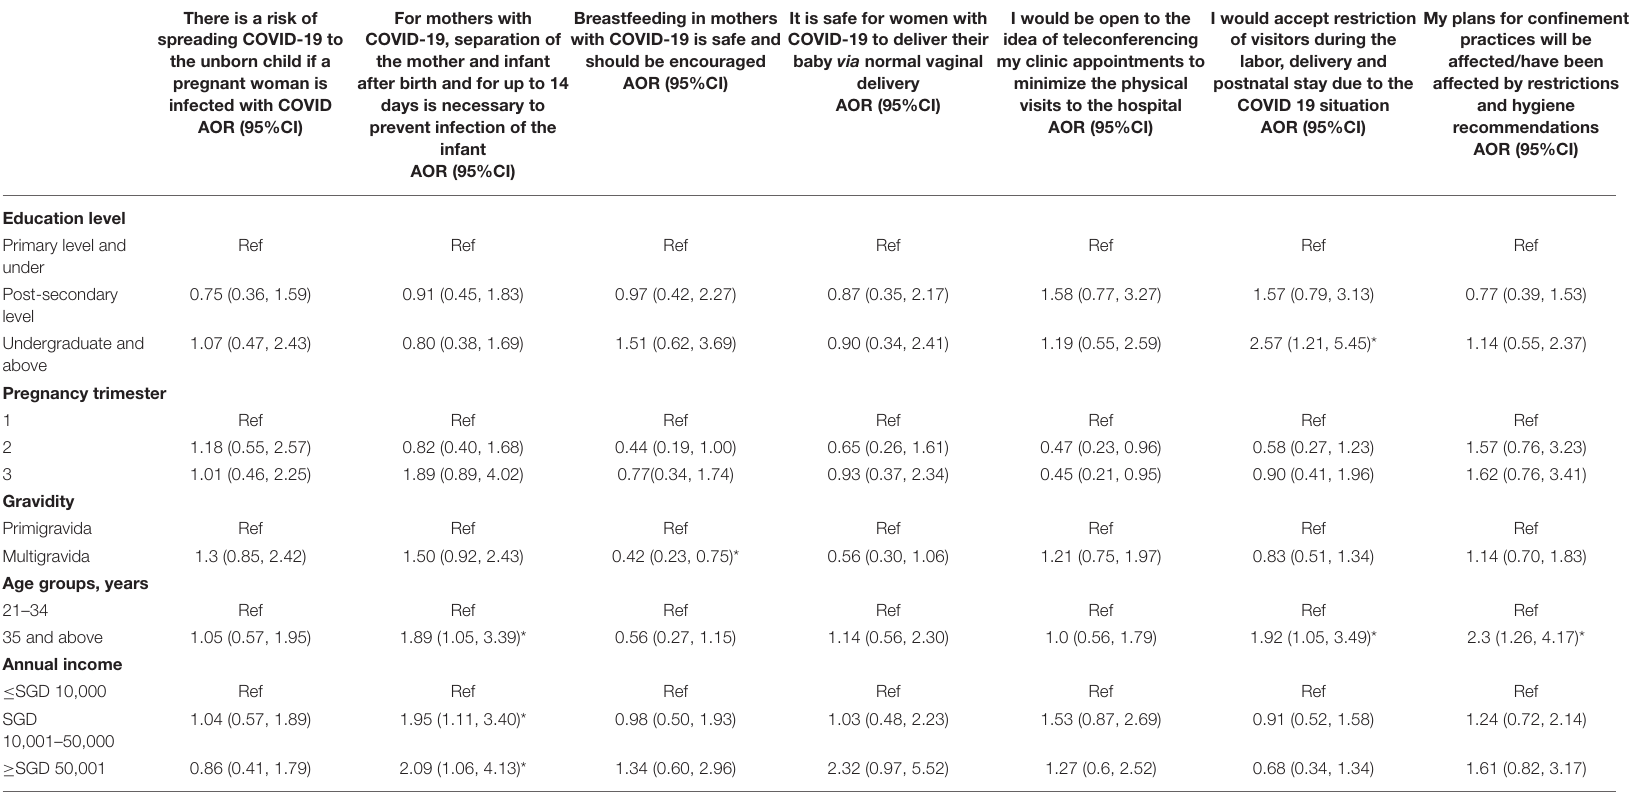
TABLE 4 | Multivariable analysis of factors affecting pregnant women’s understanding and expectations of perinatal and neonatal care. There is a risk of spreading COVID-19